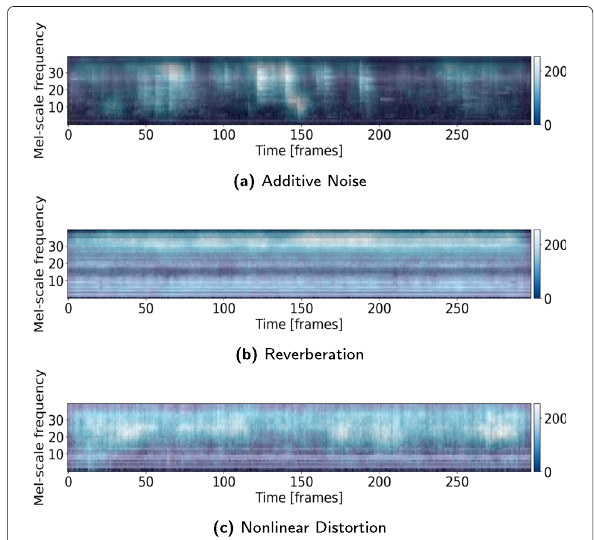
Fig. 3 Visualization of the saliency map, plotted in blue shading on top of the gray-scale signal spectrogram, by applying the score-CAM method to the log-mel spectrogram of a pathological voice signal (sustained vowel /a/) degraded by three types of degradation. The intensity of the saliency map, shown on a scale of 0 to 255 by the colorbars, illustrates the importance of each region of the input space to the target